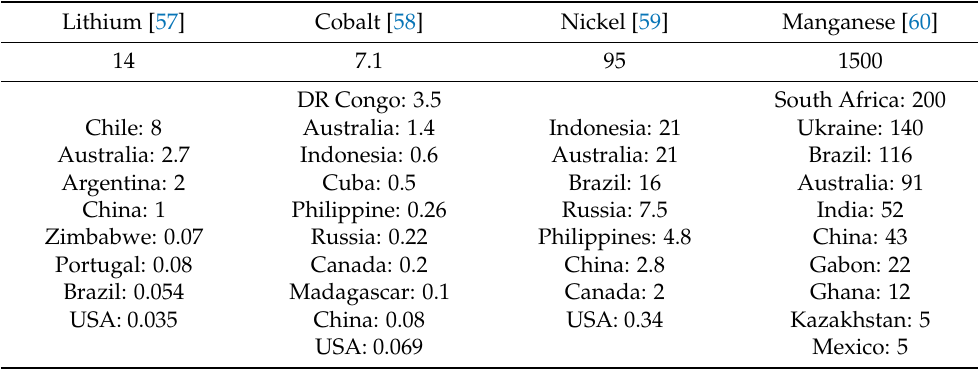
Table 4. Global reserves of lithium, cobalt, nickel, and manganese (million tons). Lithium [57] Cobalt [58] Nickel [59] Manganese [60] 14 7.1 95